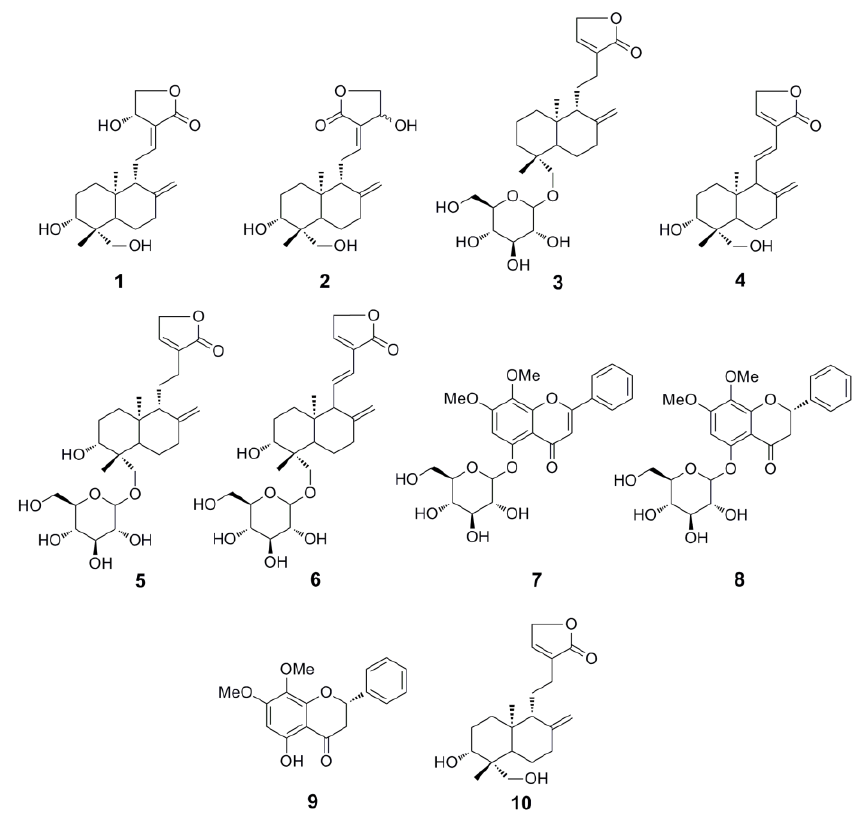
Figure 1. Chemical structures of compounds 1 – 10 .